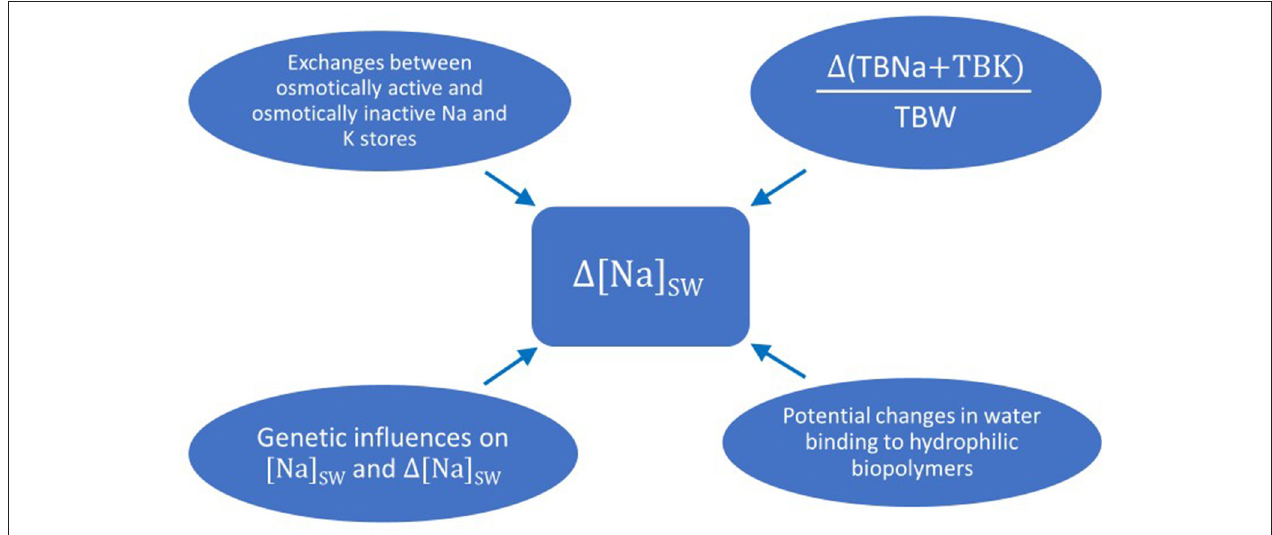
FIGURE 2 | Potential influences on the magnitude of the change in sodium concentration in serum water when there is a change in the fraction (total body sodium plus total body potassium) over total body water. 1 (TBNa + TBK)/TBW: change in the fraction (total body sodium plus total body potassium) over total body water; 1 [Na] SW : change in sodium concentration in serum